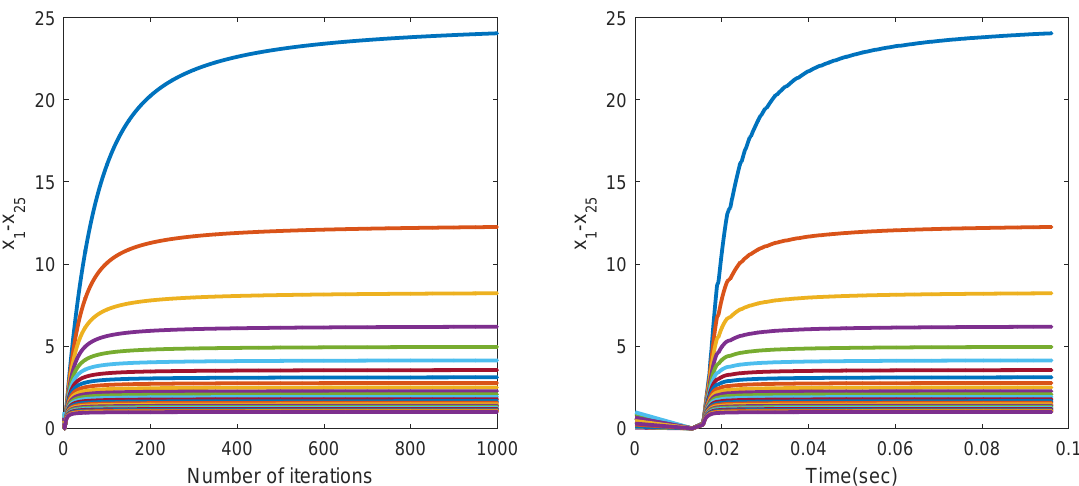
Figure 5. Behaviors of x 1 – x 25 with the number of iterations (resp.) k = 1000. Numerical results for Algorithm